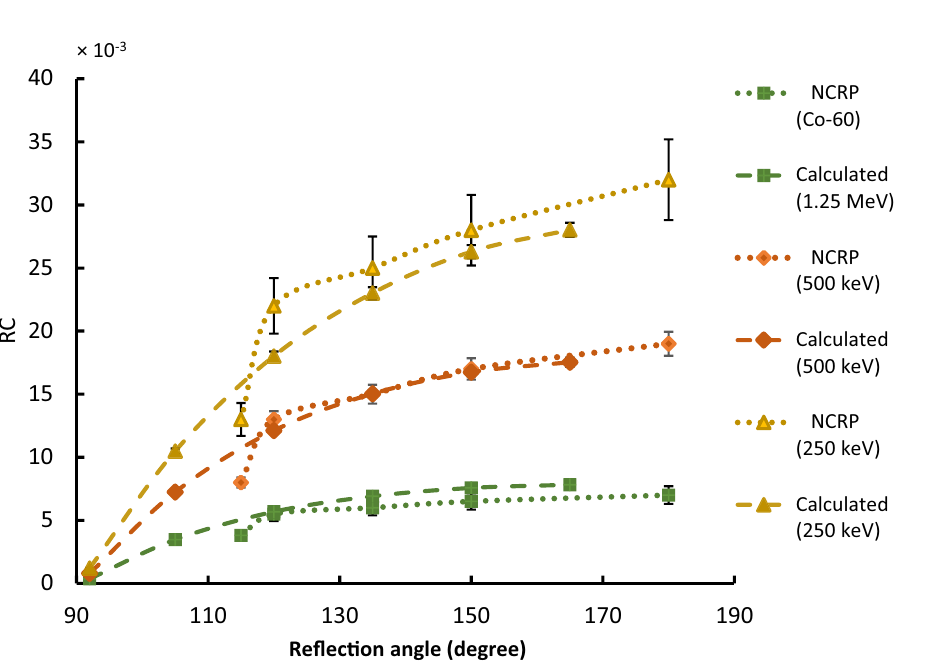
Figure 2. Comparisons between the backscattered photons of ordinary concrete of NCRP data and FLUKA calculations as a function of reflection angles (with respect to the incident trajectory, normal to the